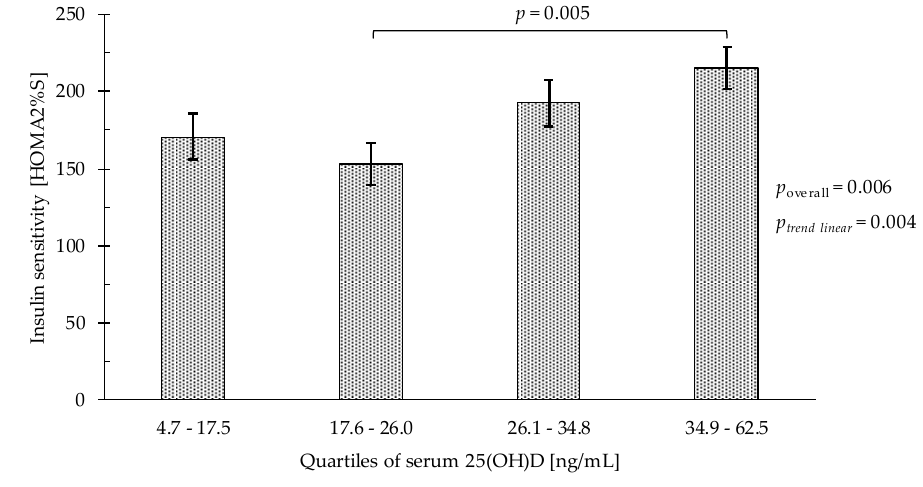
Figure 3. Insulin sensitivity (HOMA2%S) by serum 25(OH)D quartiles ( n = 256), 1 ng/mL 25-hydroxyvitamin D being equivalent to 0.4 nmol/L. Bars represent least-square means (with whisker for standard error) from multivariable linear regression models. Models were adjusted for age, sex, MVPA, smoking status (non, past, and current smoker) and body mass index. 25(OH)D, 25-hydroxyvitamin D; MVPA, moderate to vigorous physical activity (min/day).